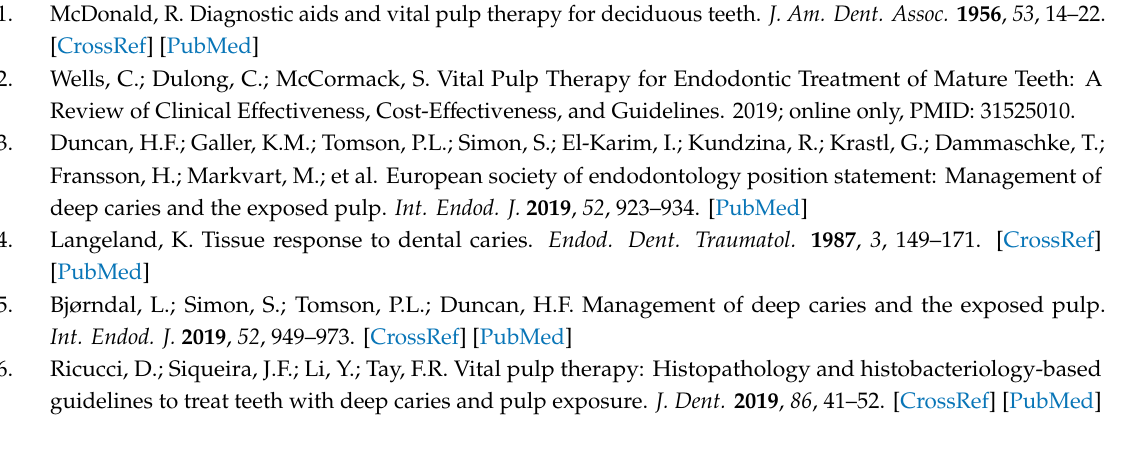
Table S1: Prisma checklist, Table S2: Example of search strategy, Table S3: Studies excluded after full text evaluation, Table S4: Bias